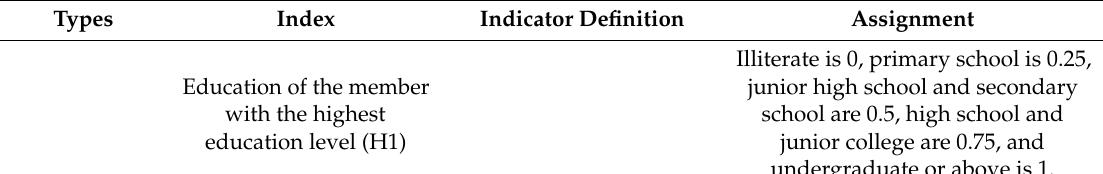
Table 1. System of living assets measurement indicators and weights of land-lost farmers’